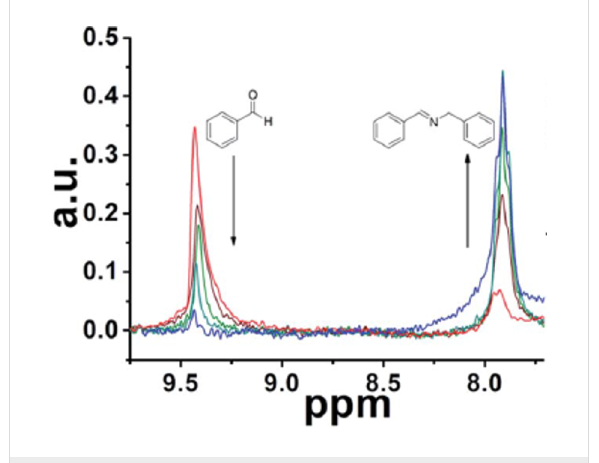
Figure 14: NMR analysis of the reaction of benzaldehyde (2 M in CH 3 CN) and benzylamine (2 M in CH 3 CN) (1:1), residence time, 30 min. Reproduced with permission from reference [50]. Copyright 2015 The Royal Society of